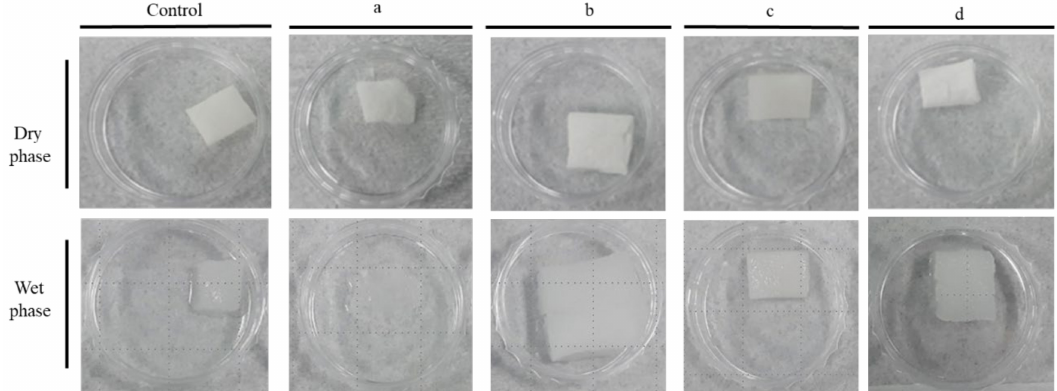
Figure 6. Photographs of subsequent lyophilization (dry phase, top ) and water absorption (wet phase, bottom ); control sponge, ( a ) Alg-CMC ratio (5:5); ( b ) Alg-CMC ratio (5:5) with dextran; ( c ) Alg-CMC ratio (7:3); ( d ) Alg-CMC ratio (7:3) with dextran.